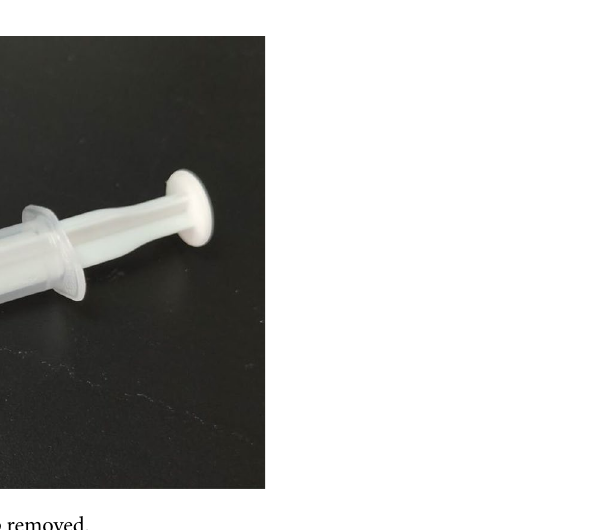
Figure 1. Bumblebees in the wooden for toxicity assessment.